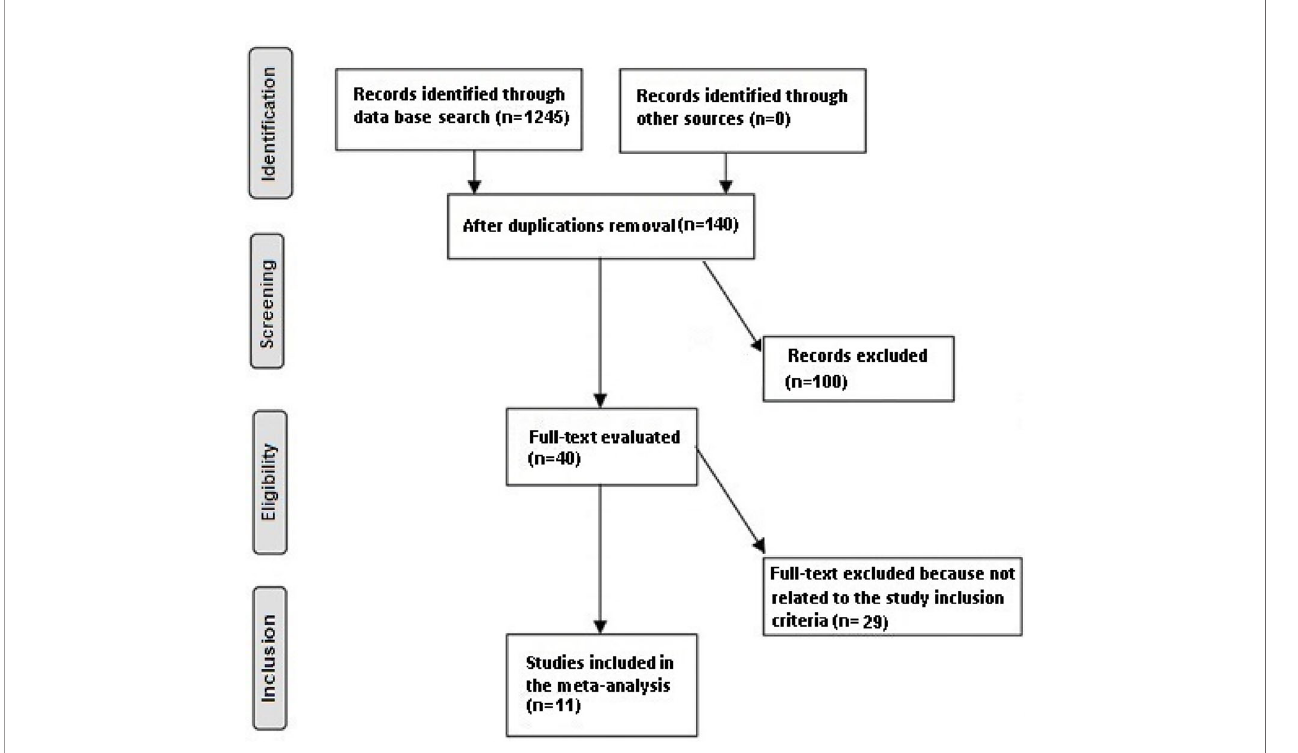
FIGURE 1 | Diagram of the study